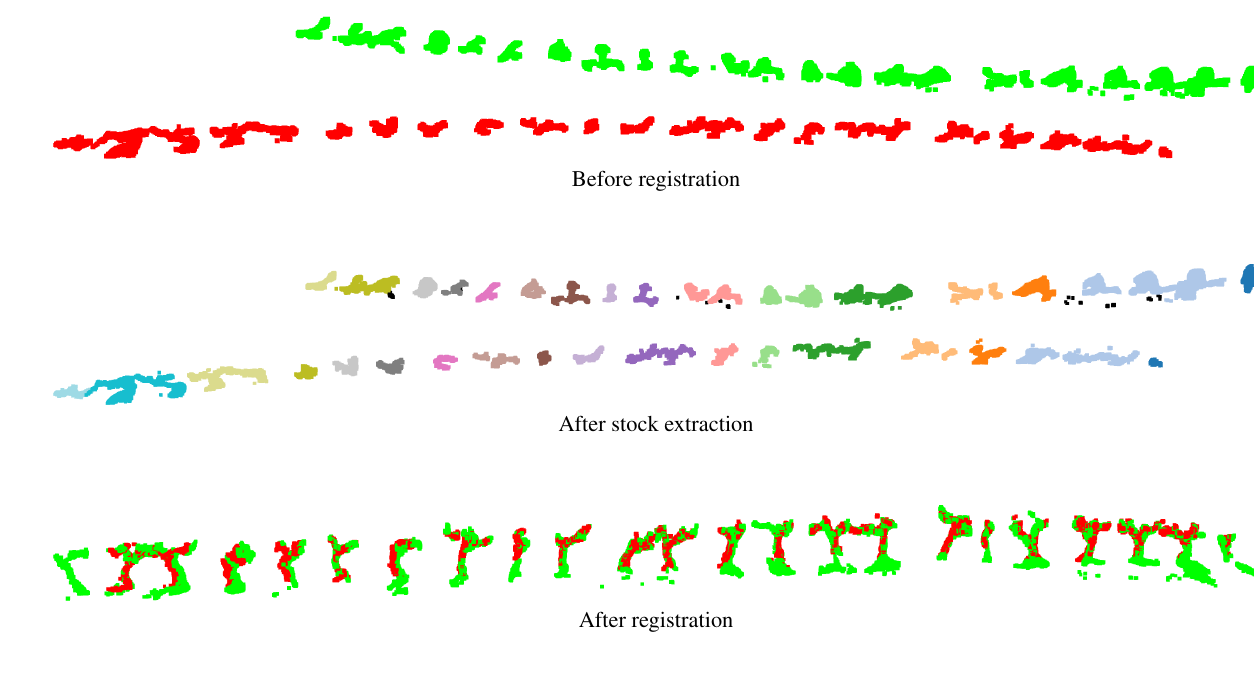
Figure 12: Result of the 3D vineyard registration (top) before registration, (center) after 3D stocks extraction (one color per detected stock), and (bottom) after registration : the reference dataset (green) and the target one